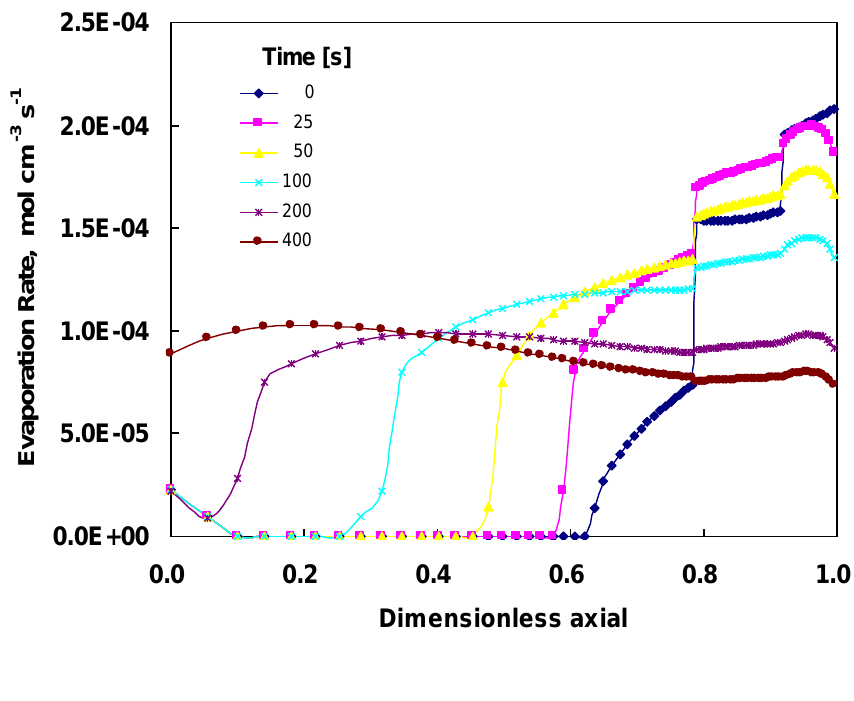
Figure 11. Distribution profile of evaporation rate during a step change of potential from 0.9 V to 0.4